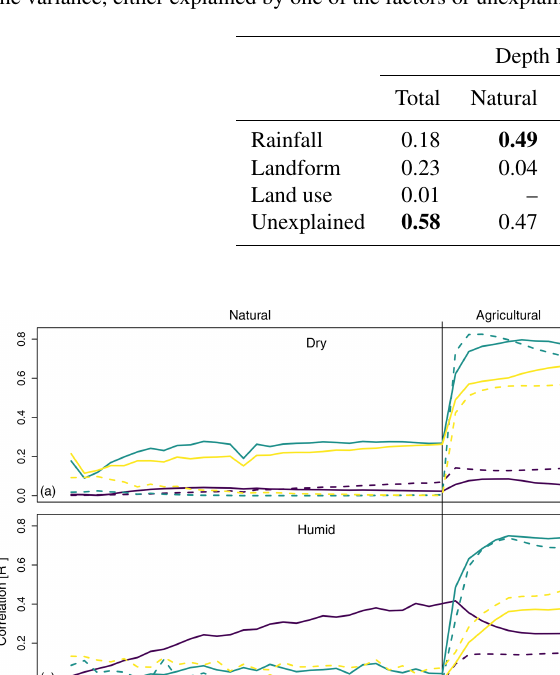
Table 3. Results from the analysis of variance, indicating the proportion of variance in soil properties explained by the different soil-forming factors. The data are both considered in total and grouped per land use (natural or agricultural). The bold numbers indicate the largest part of the variance, either explained by one of the factors or unexplained. All responses are significant ( p< 0 . 05).